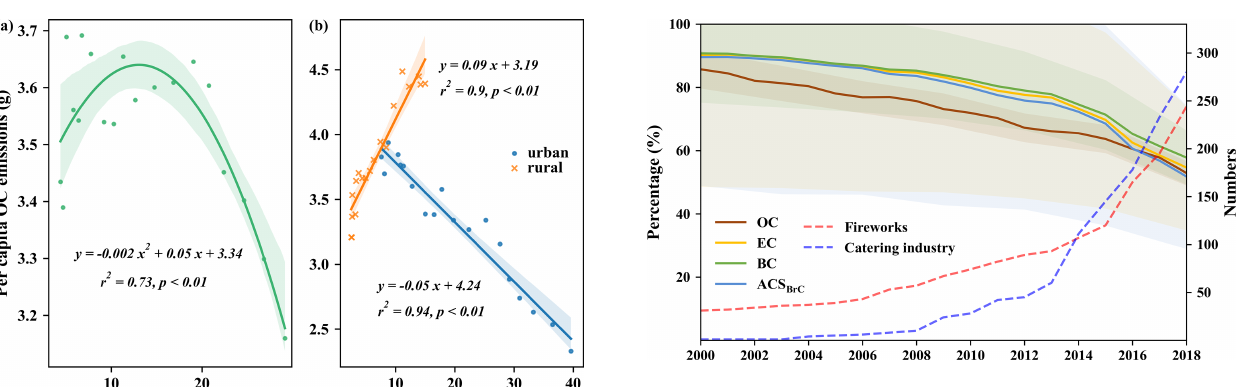
Figure 10. The impact of policies on the reduction of CA emis- sions. The solid lines (left y axis) represent the actual CA emissions compared with the emissions without the policy impact (100% on the left y axis). The shaded part of the solid line represents uncer- tainties. The dotted lines (right y axis) represent the number of cities that issued policies to control the FMSs’